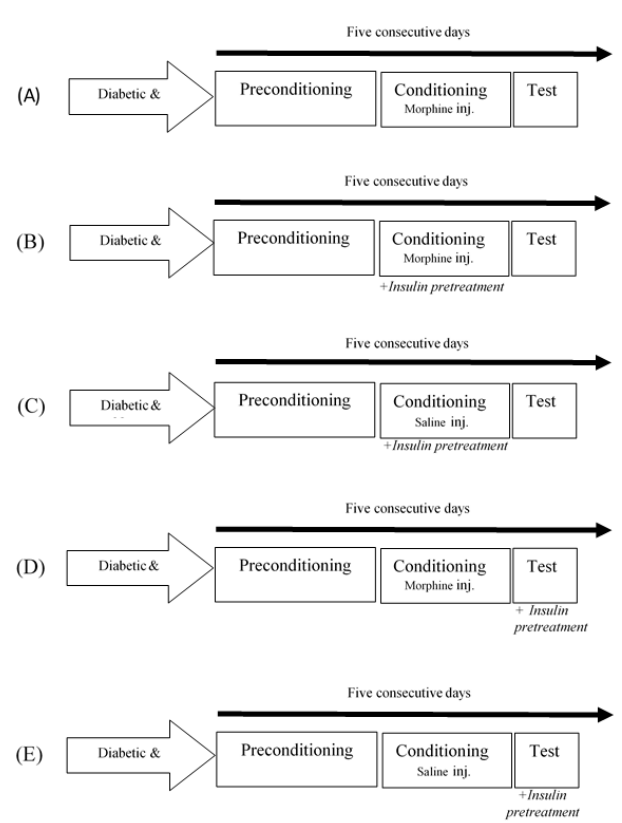
FIGURE 1 - Graphical scheme of CPP protocols in experimental groups (diabetic and naïve) of the present study. Both groups are divided into three subgroups, that these subgroupings are demonstrated in this figure. (A) CPP protocol in diabetic and naïve to determine CS induced by morphine without insulin pretreatment (first subgroup). (B) and (C) CPP protocol to determine CS induced by morphine and saline in addition to insulin pretreatment in three consecutive conditioning days (second subgroup). (D) and (E) CPP protocol to determine CS induced by morphine and saline with insulin pretreatment in test day (third